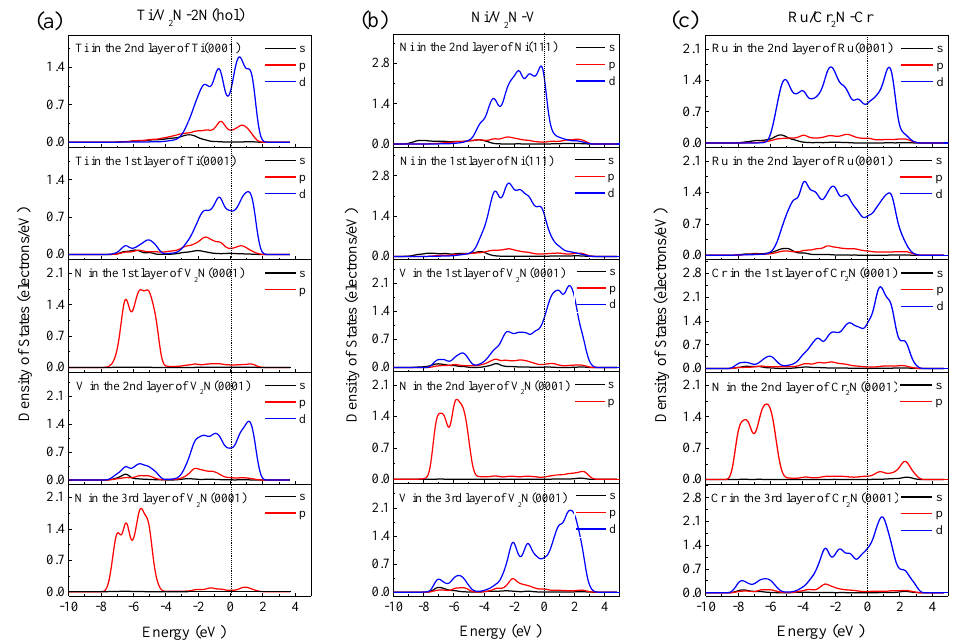
Figure 7. PDOS for selected atoms in the ( a ) Ti(0001)/V 2 N(0001)-2N(hol), ( b ) Ni(111)/V 2 N(0001)-V, and ( c ) Ru(0001)/Cr 2 N(0001)-Cr interface models. The vertical dashed line indicates the Fermi level.